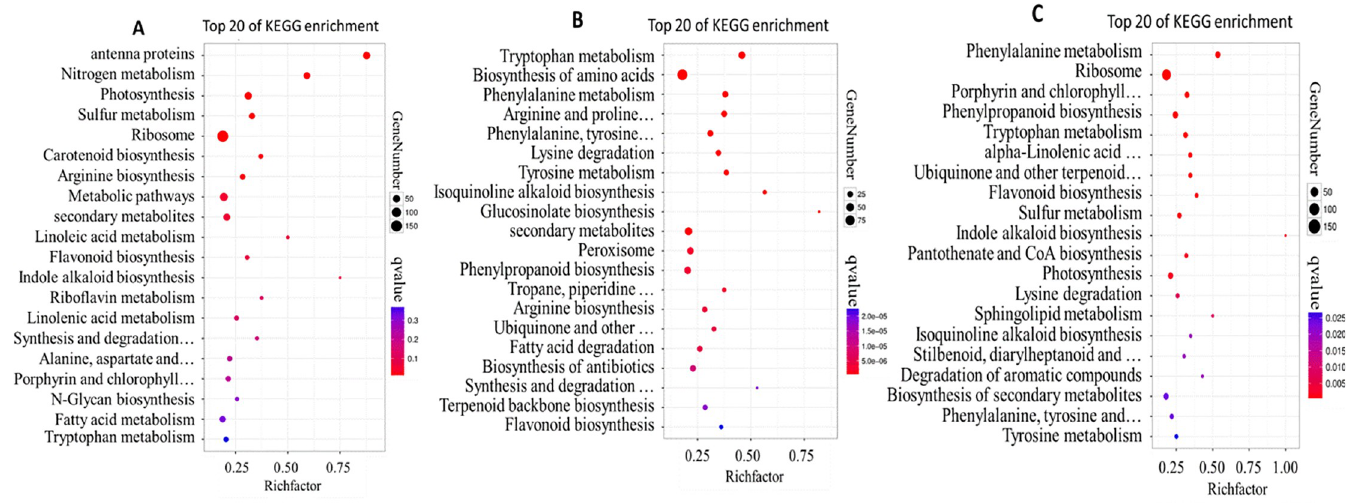
Fig 4. KO pathways enrichment analysis of DAPs between two varieties under cold for 12 h (B) and 24 h (C), and control treatment (A).